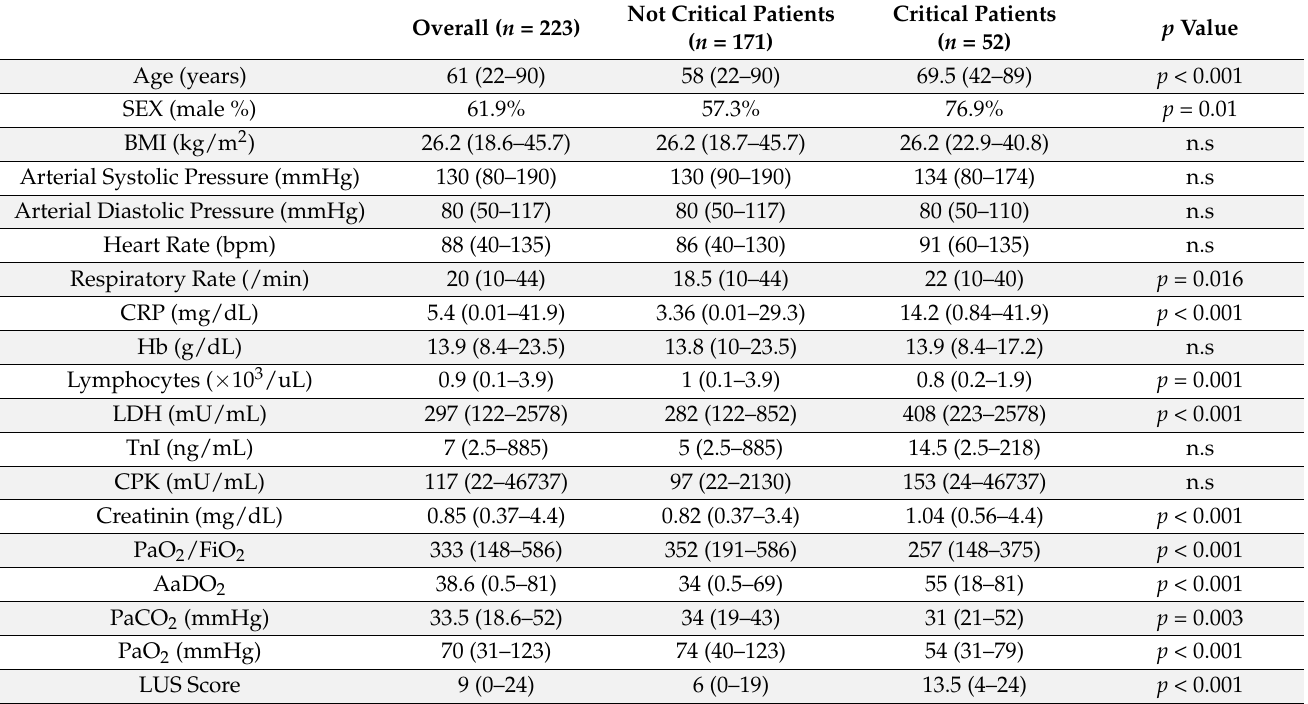
Table 1. Patients baseline